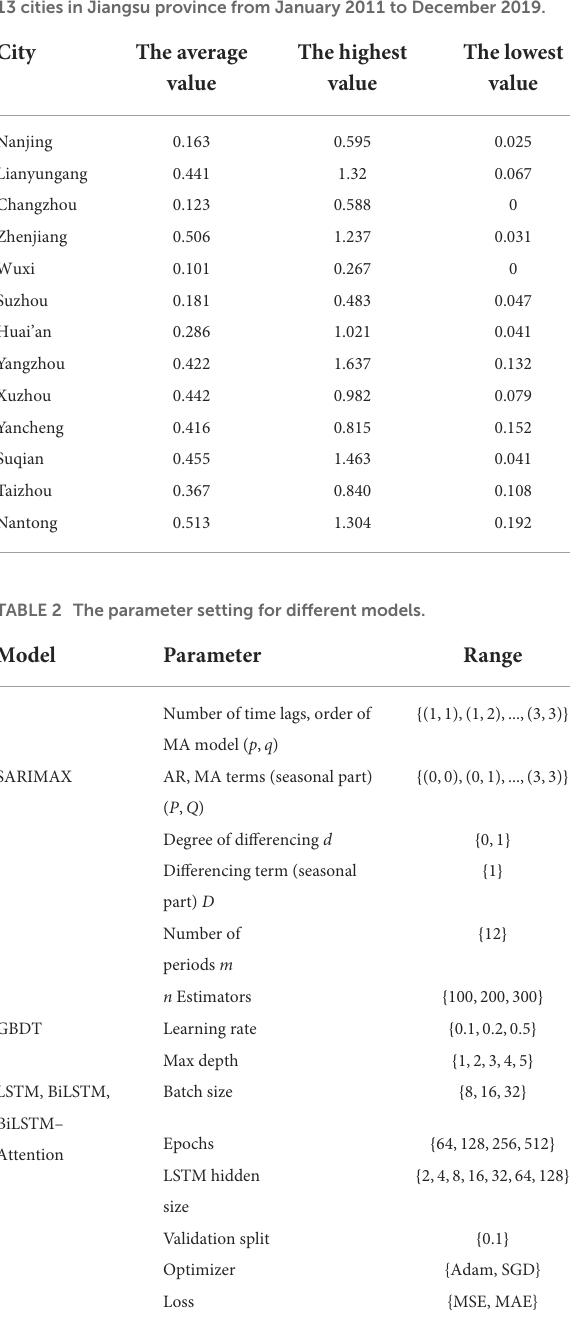
TABLE 1 Statistics of the monthly incidence rates of hepatitis E for the 13 cities in Jiangsu province from January 2011 to December 2019. City